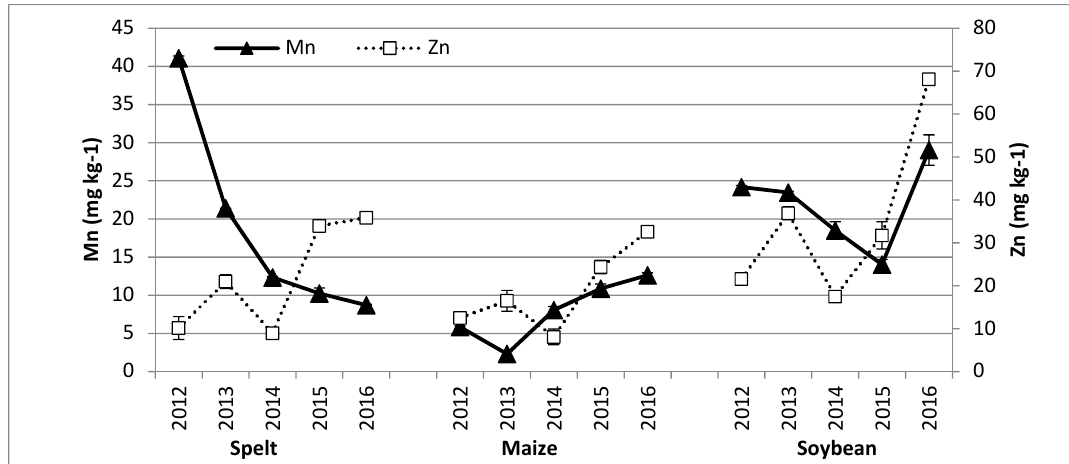
Figure 10. The variation of Mn and Zn concentration in grain of organically produced spelt, maize, and soybean (bars represent SD values).